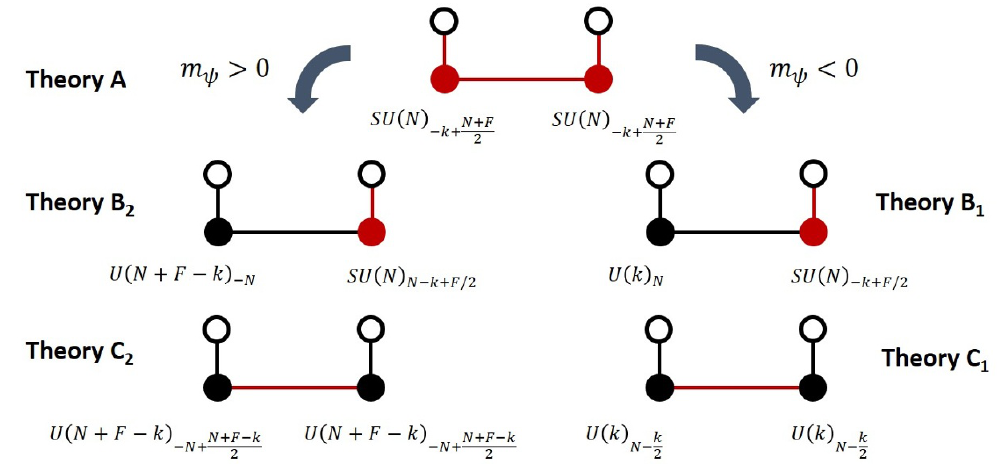
Figure 7 . Phase diagram of the two-node quiver with extra (cid:13)avors on each node and explicit Z 2 symmetry. Here the white nodes represent global (cid:13)avor symmetries of the extra matter. Once more, the splitting of the bottom two phase diagrams results from the use of the (cid:13)avor-violated 3d bosonization duality. We assume N > k and F < k